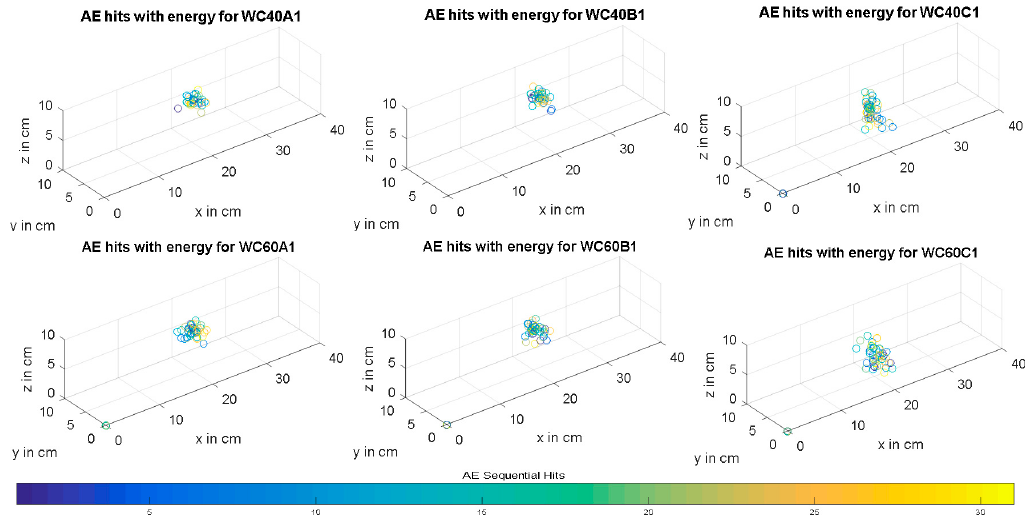
Figure 11. Acoustic emission (AE) hits from L1 to L4 for the six variations of RC beams.